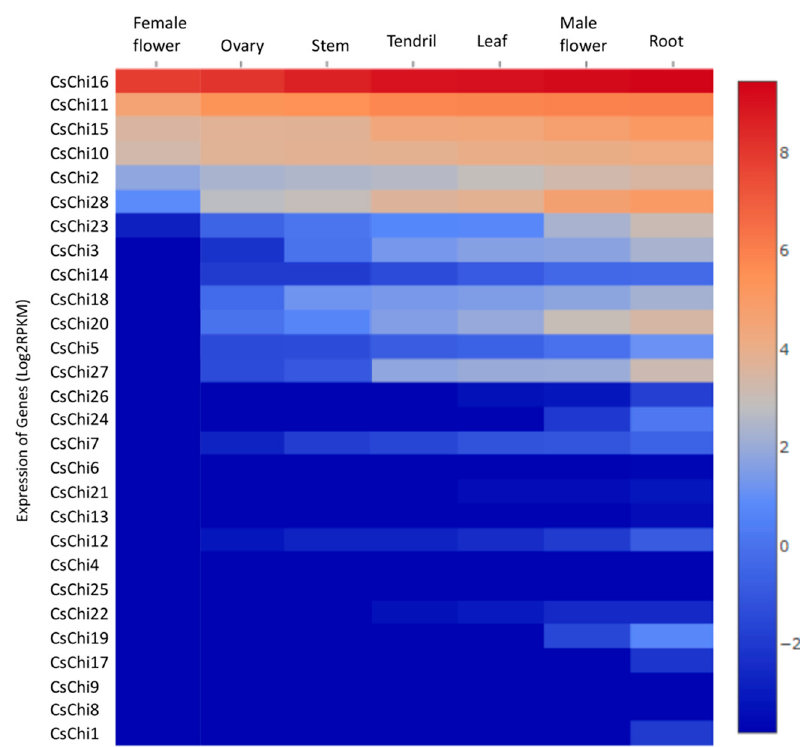
Figure 4. Heat map representation of chitinase genes expression in different cucumber tissues. The expression data was converted with Log2 (RPKM) to calculate gene expression levels. Gene expression differences are shown in the colors indicated in the scale. The RNA-Seq data used here could be downloaded from http://www.ncbi.nlm.nih.gov/bioproject/PRJNA80169/.